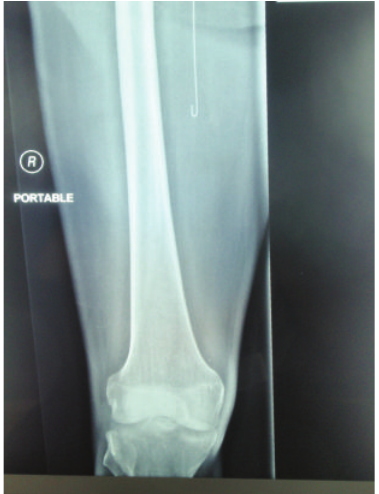
Figure 4: Right thigh X-ray showing the J-tip of the lost guidewire medial to the